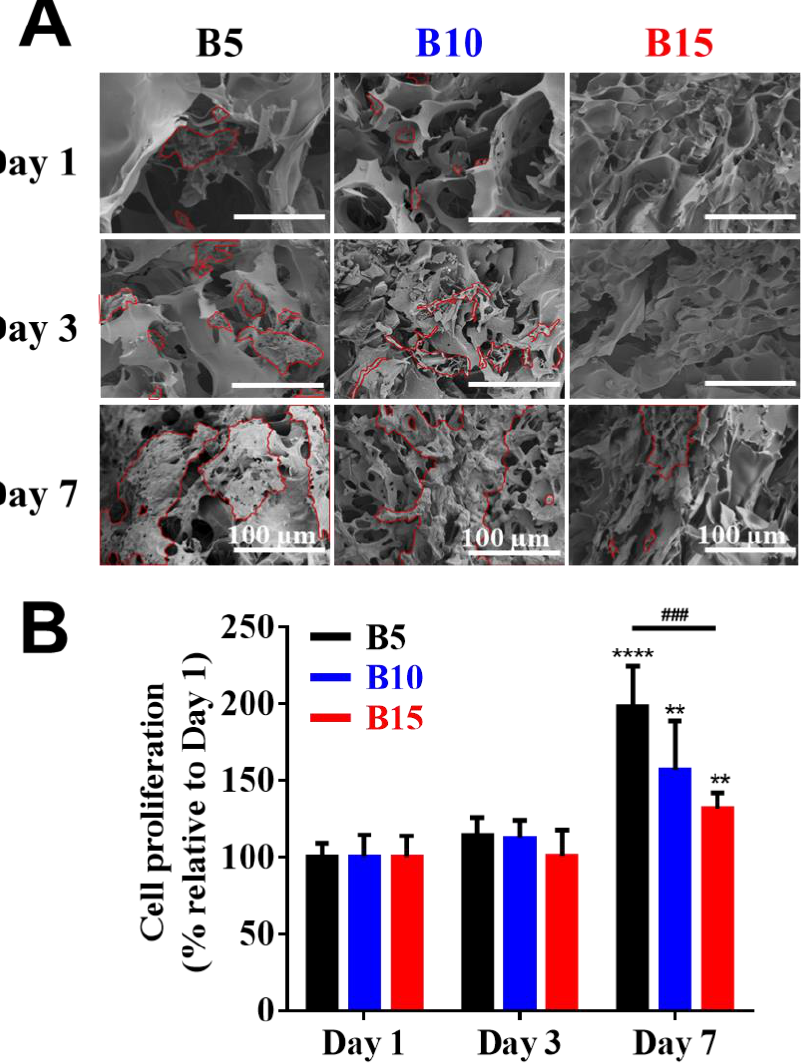
Figure 4. Cell viability on BSAMA cryogels (B5, B10, and B15) for 7 days. ( A ) SEM images of the inside of cell-laden cryogels at day 1, day 3, and day 7. The outline of cells is marked in red. Scale bar: 100 µ m. ( B ) Cell proliferation. n = 3, **: p < 0.01, ****: p < 0.001, compared to the same cryogel type on the day 1. ###: p < 0.005, between the samples at the extremities of the line.